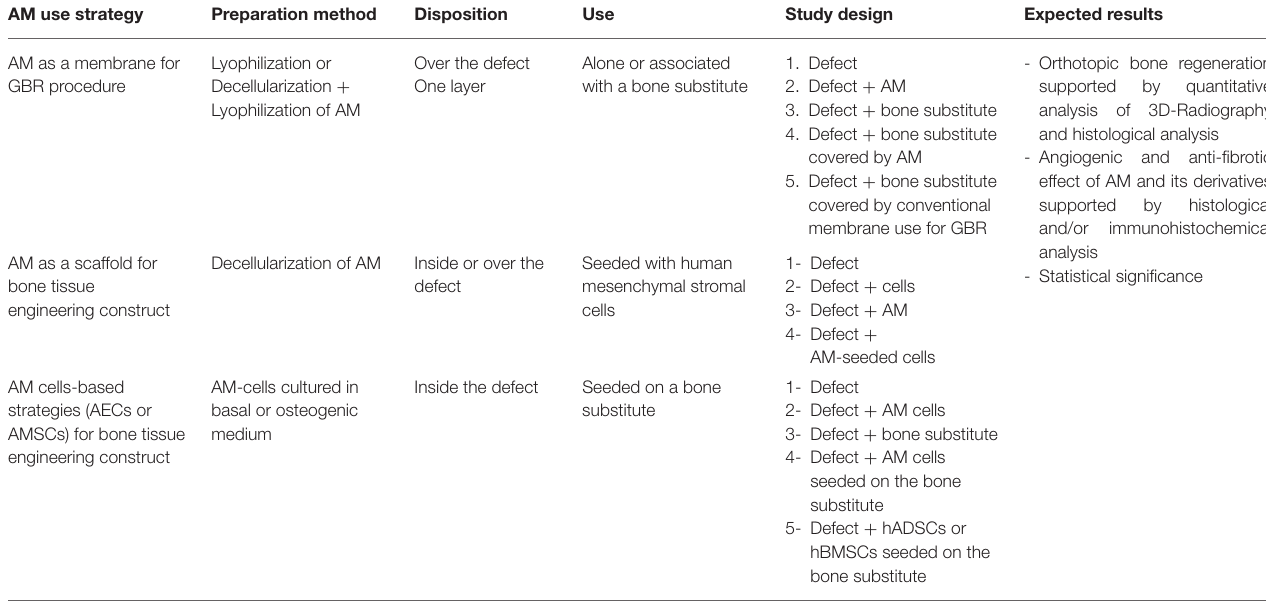
TABLE 7 | Strategies suggestion to perform a study on AM or AM derived products in the field of bone